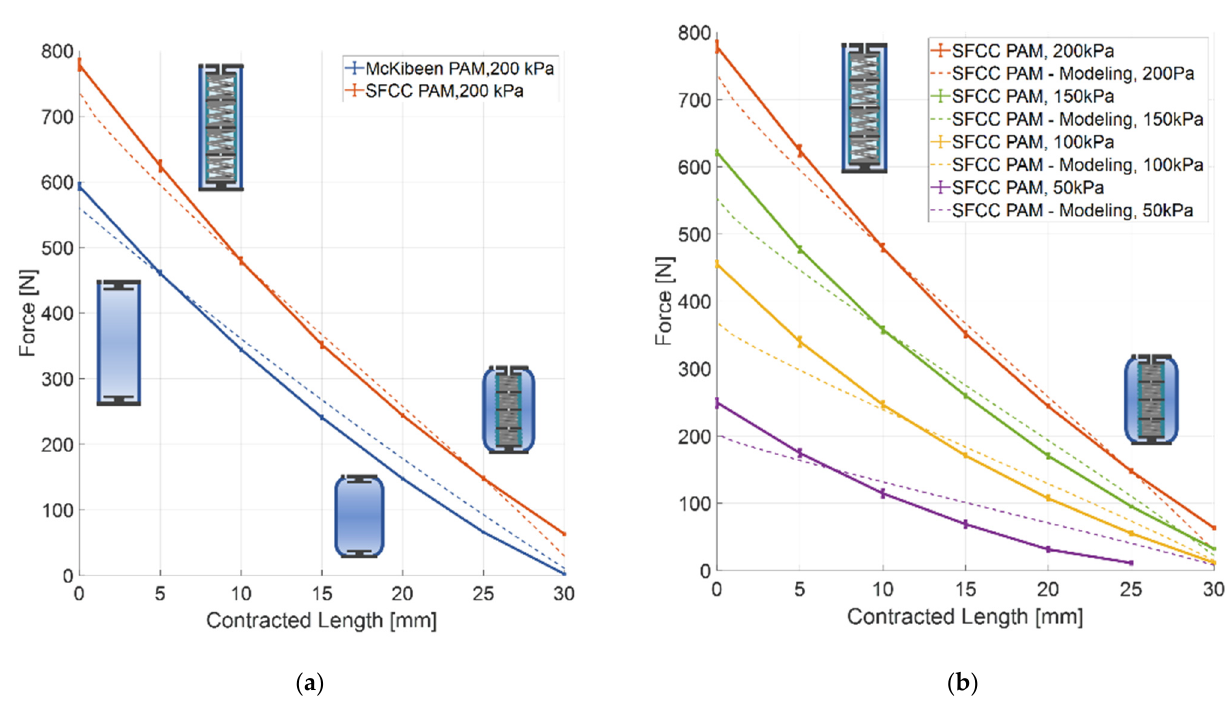
Figure 5. ( a ) The contraction force comparison of the McKibben muscle and SFCCM PAM at 200 kPa pressure. ( b ) Force versus contraction length values of the SFCC PAM at pressure range of 50– 200 kPa.